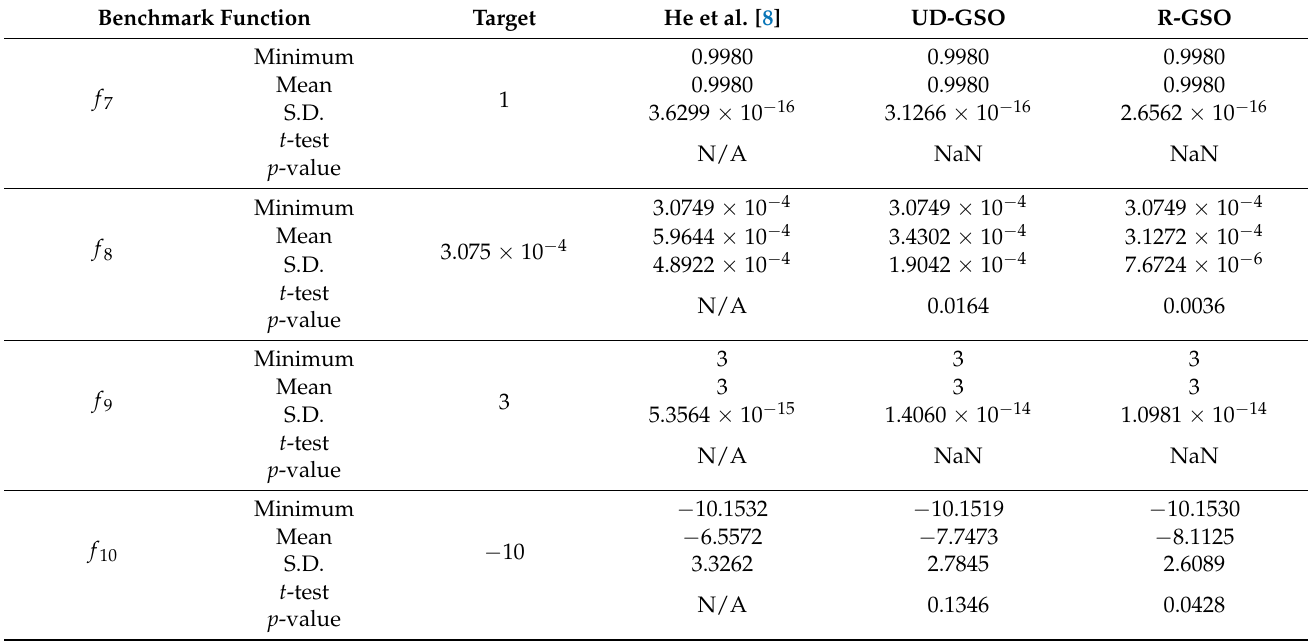
Table 14. Results comparison among GSO [8], UD-GSO, and R-GSO in restricted multimodal functions. Benchmark